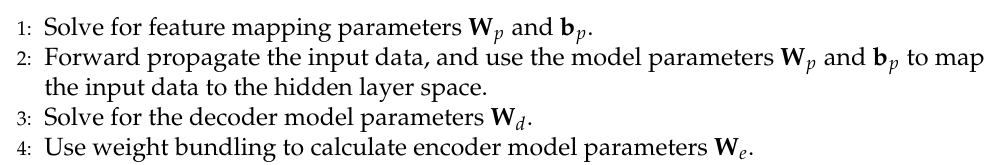
Algorithm 1 Autoencoder forward propagation